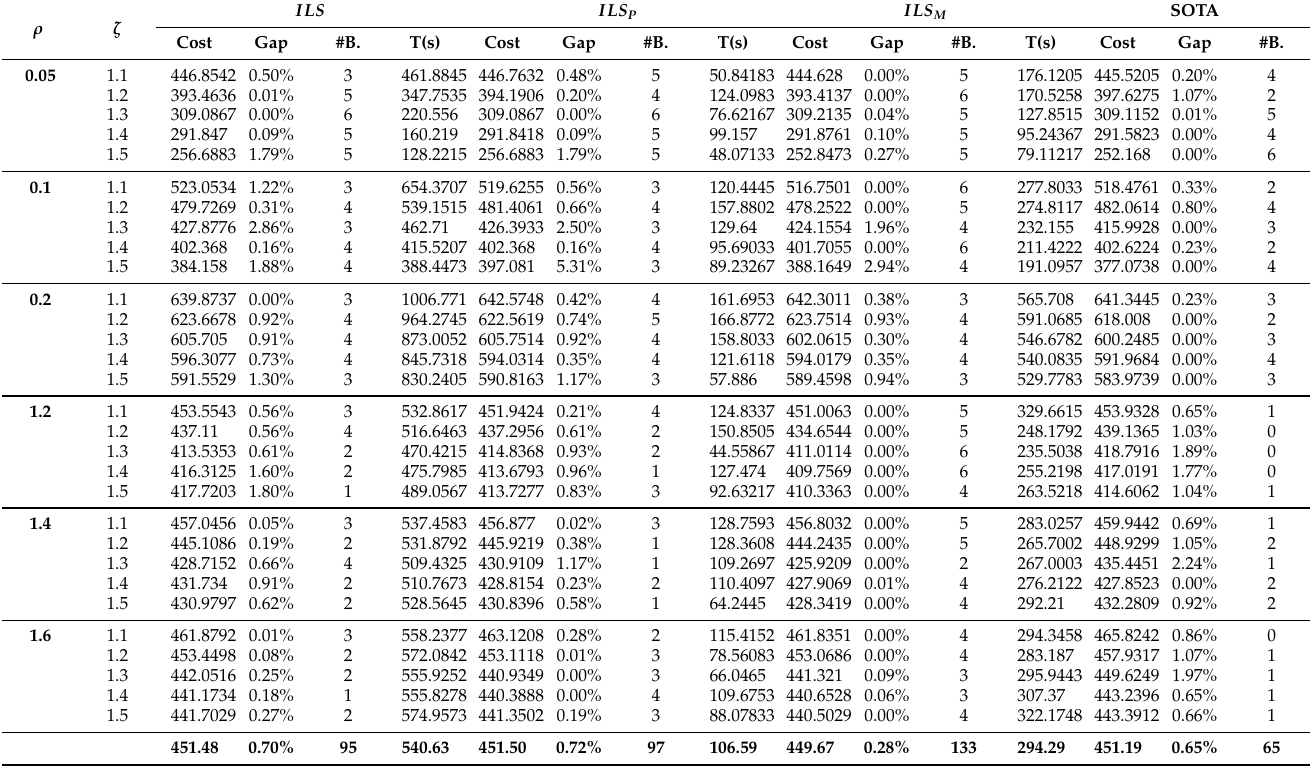
Table 7. Performance comparison for | K | = 100 occasional